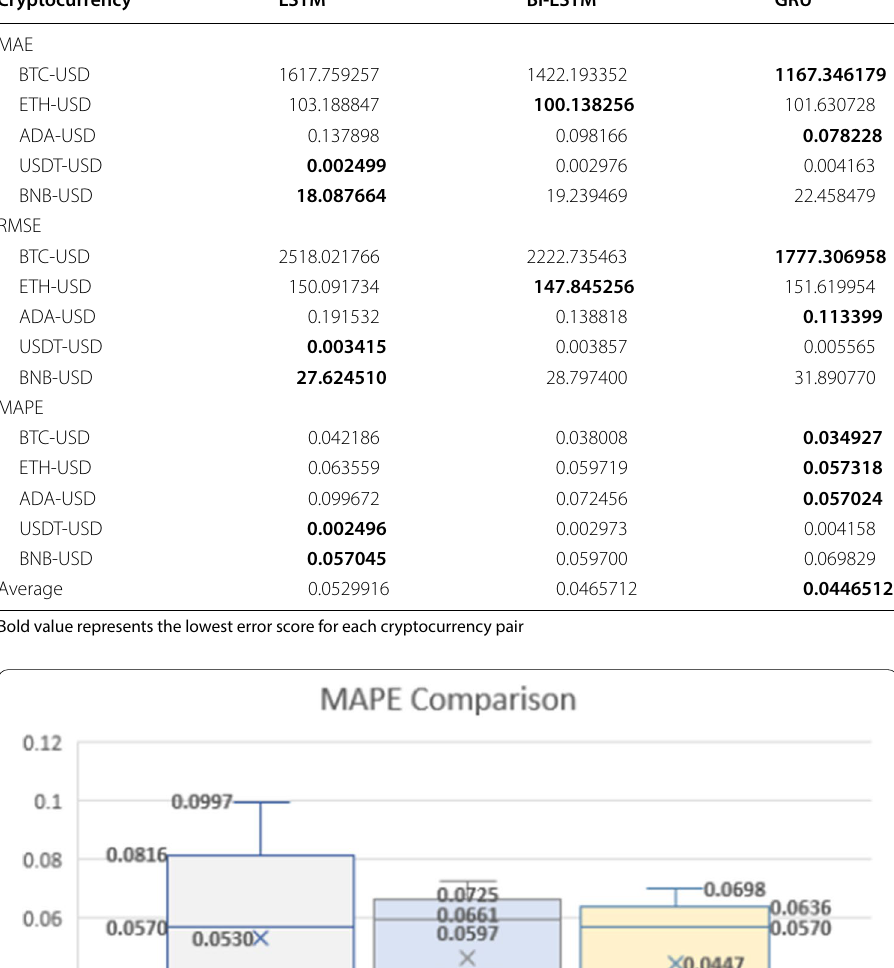
Table 2 Performance results of each cryptocurrency (average of ten consecutive running) Cryptocurrency